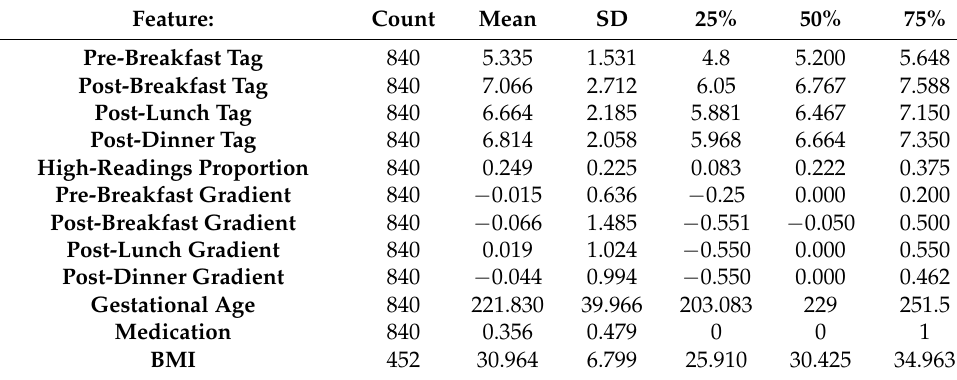
Table A1. OUH summary statistics for features used in model development. Population mean